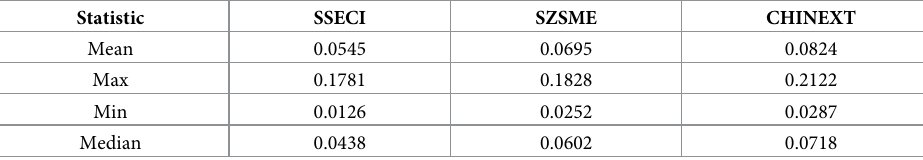
Table 6. Descriptive statistics of realized volatilities.